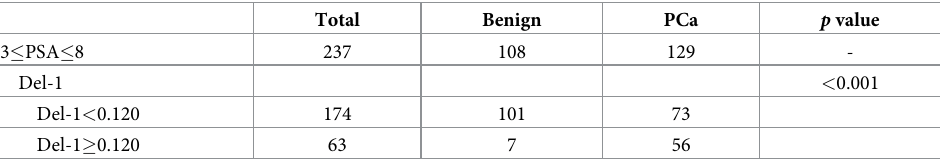
Table 3. Distribution of patients within PSA gray zone (3 � PSA �